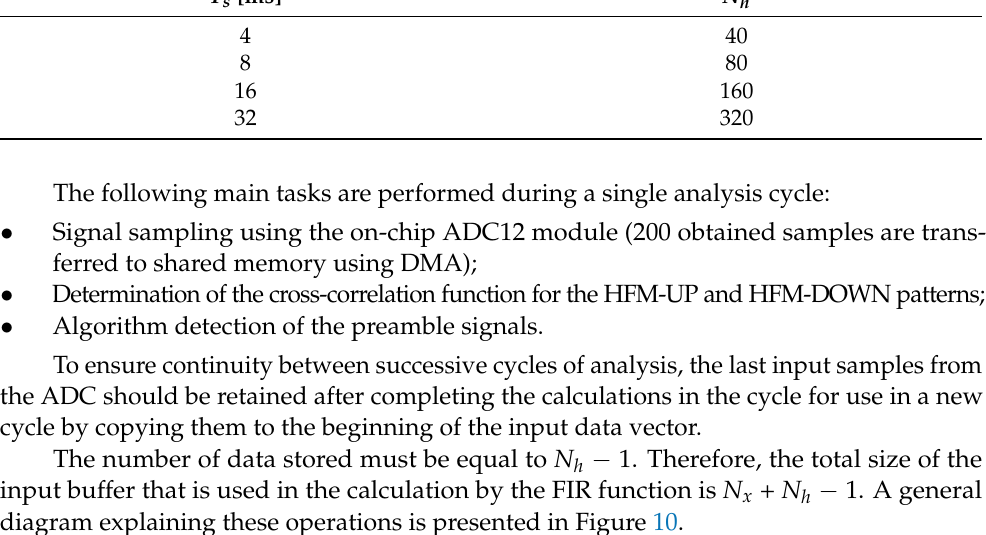
Table 8. Size of the coefficients vector depending on the signal duration.